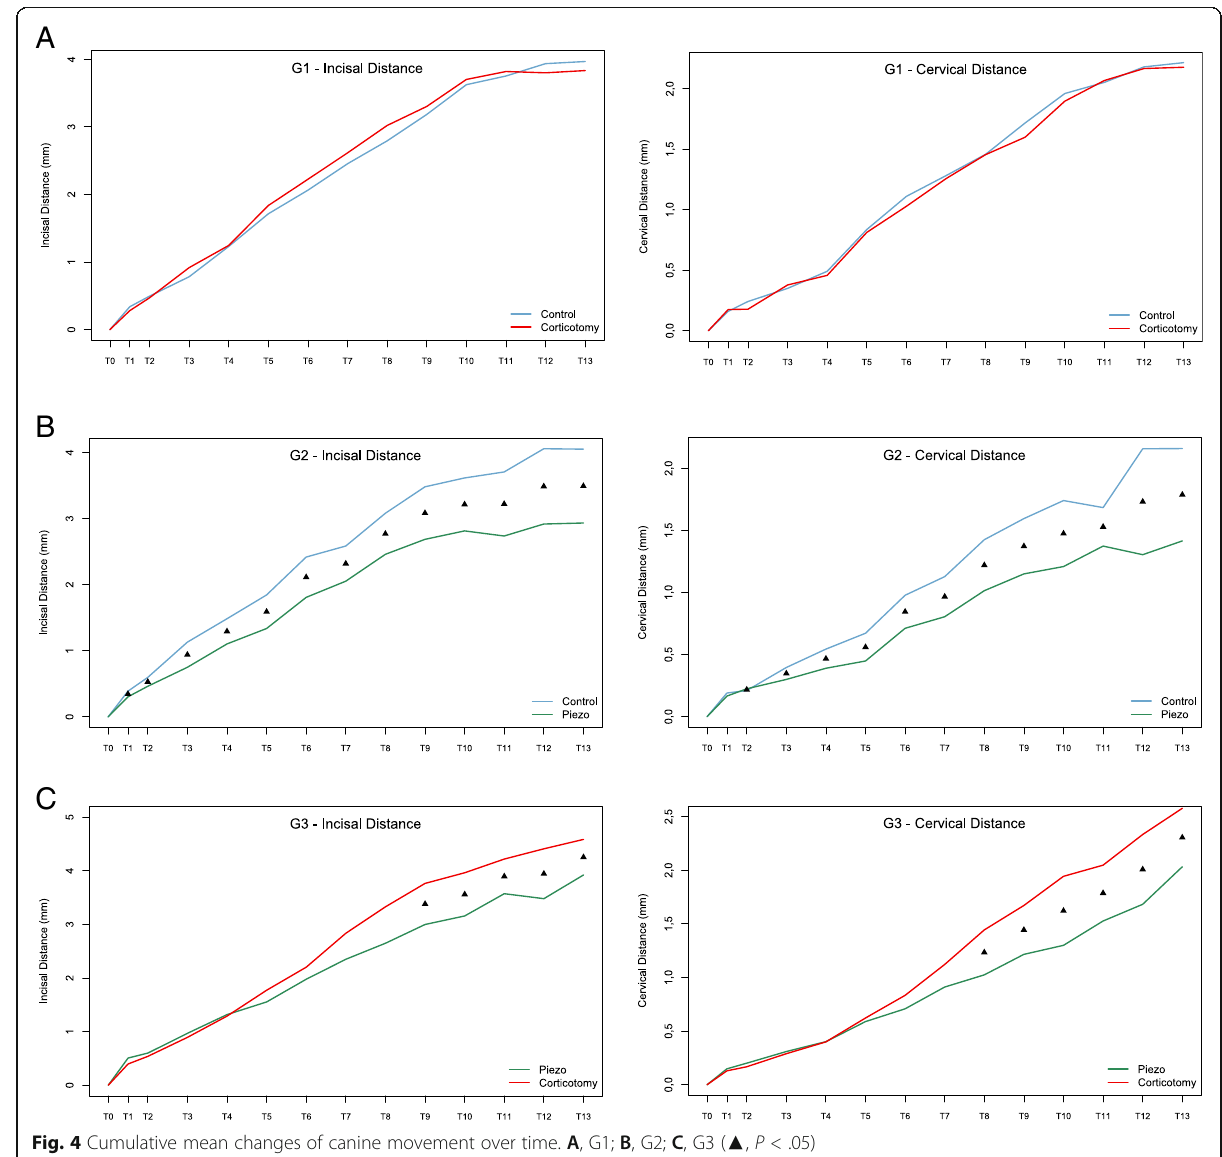
Fig. 4 Cumulative mean changes of canine movement over time. A , G1; B , G2; C , G3 ( ▲ , P <